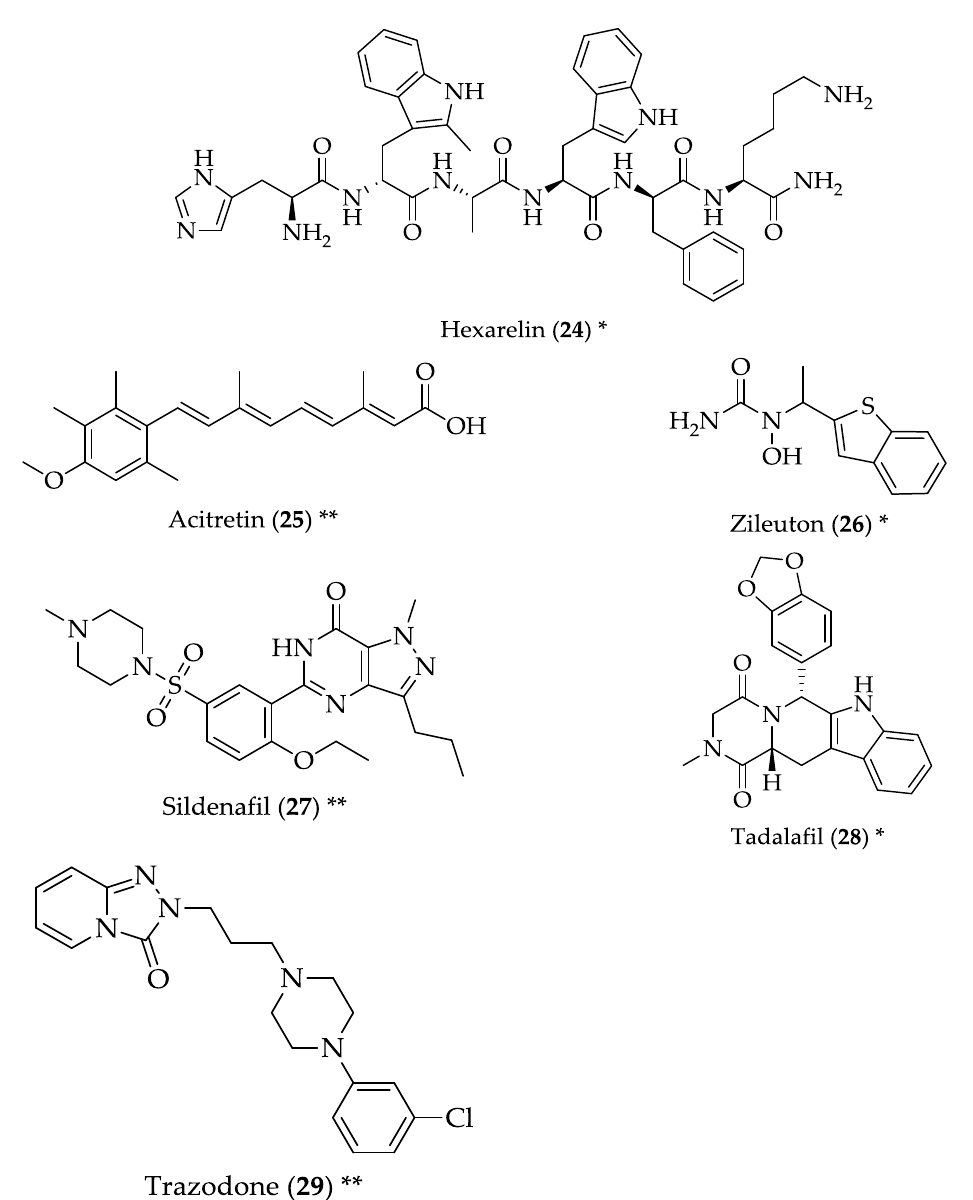
Figure 2. Structure of drugs 1 – 29 (*) Preclinical Studies; (**) Under clinical studies; (***) Clinically approved.